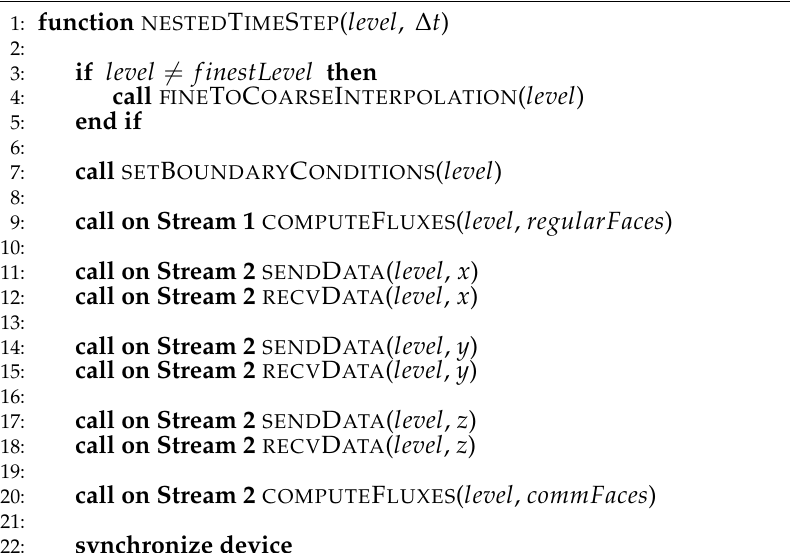
Algorithm 1 Recursive nested time stepping for